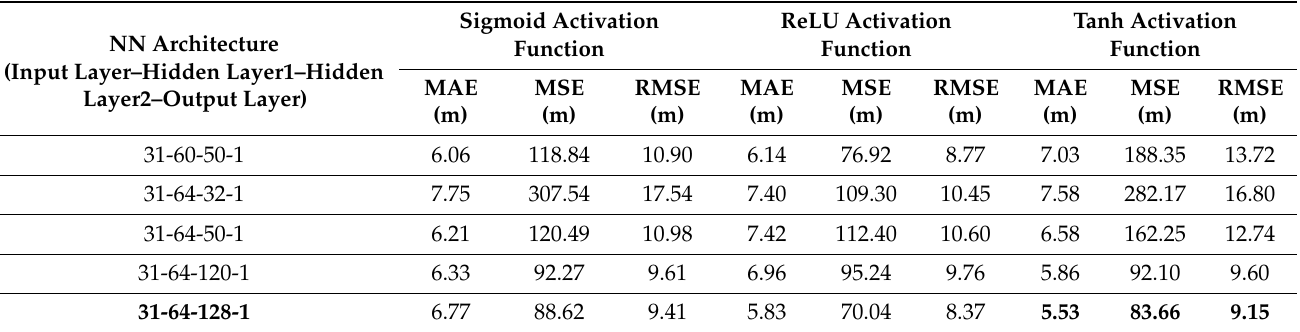
Table 4. Value for Loss parameters for different activation functions in several iterations for Dehradun and surrounding regions (Hilly region) .